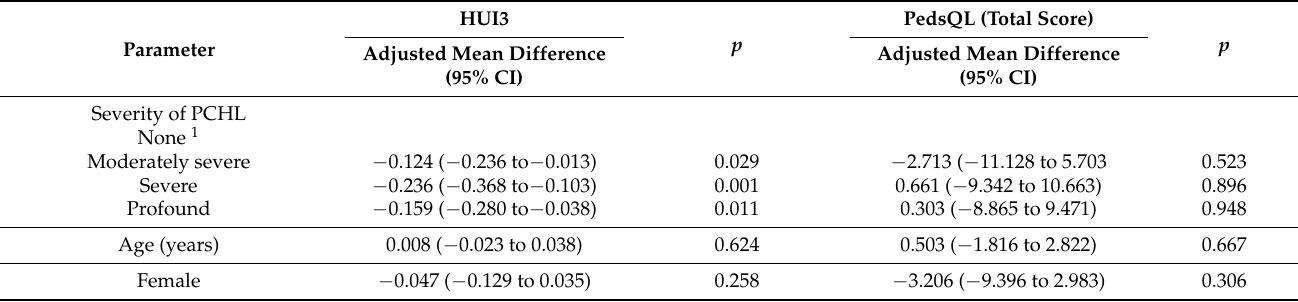
Table 5. Multivariable analyses of parent-reported HRQoL outcomes in relation to severity of hearing loss (OLS regression, fully